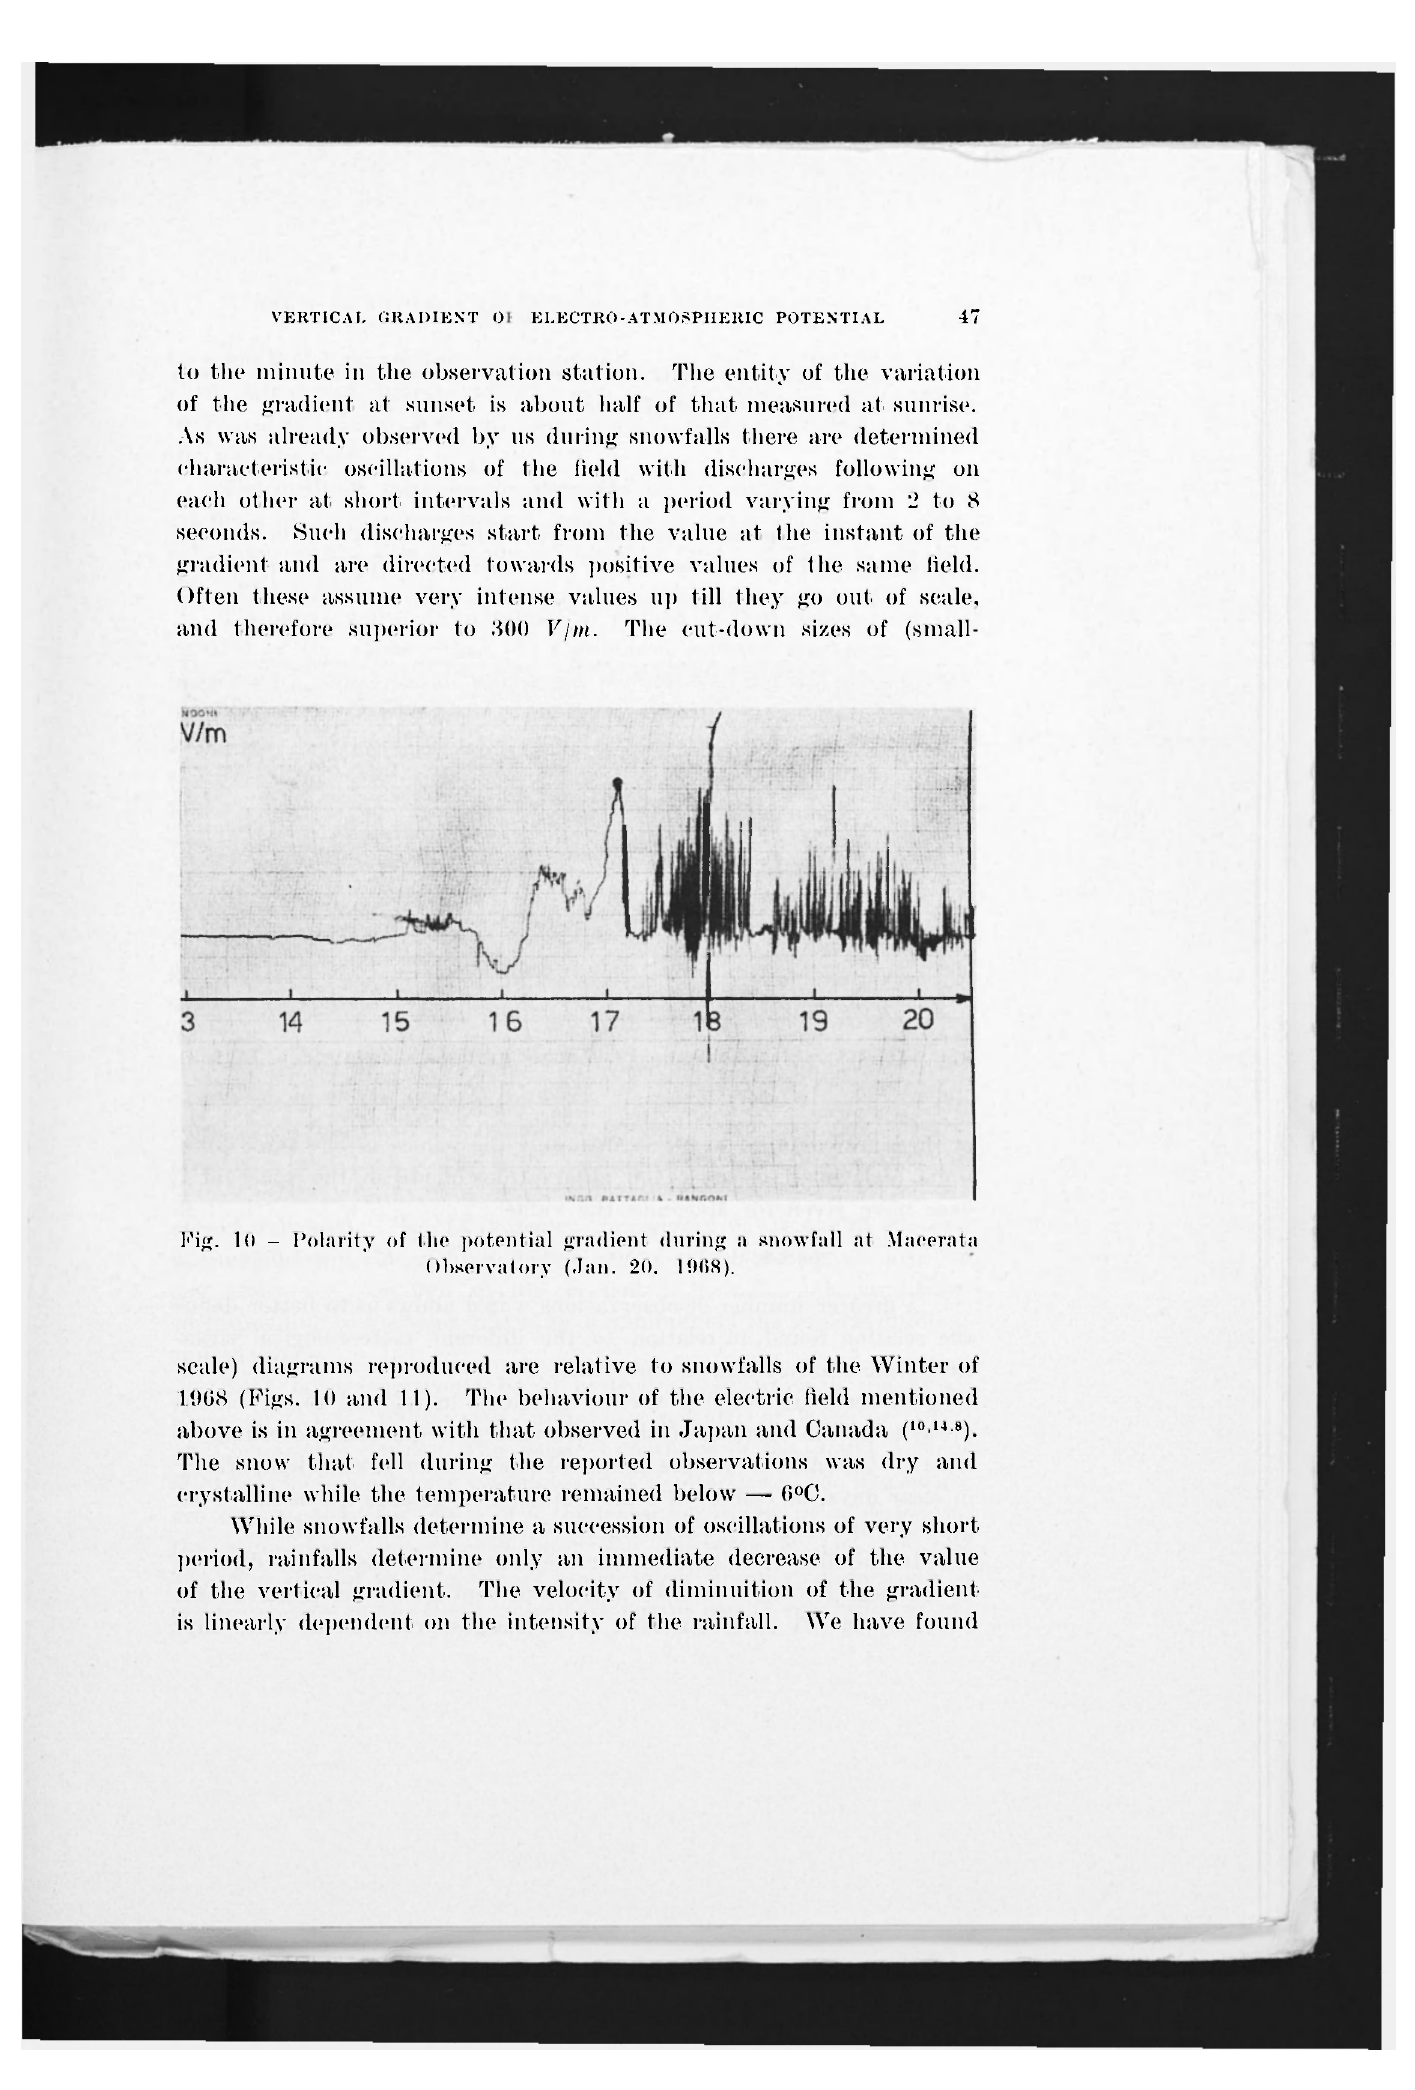
Fig. 10 - Polarity of the potential gradient during a snowfall at Macerata Observatory (Jan. 20.